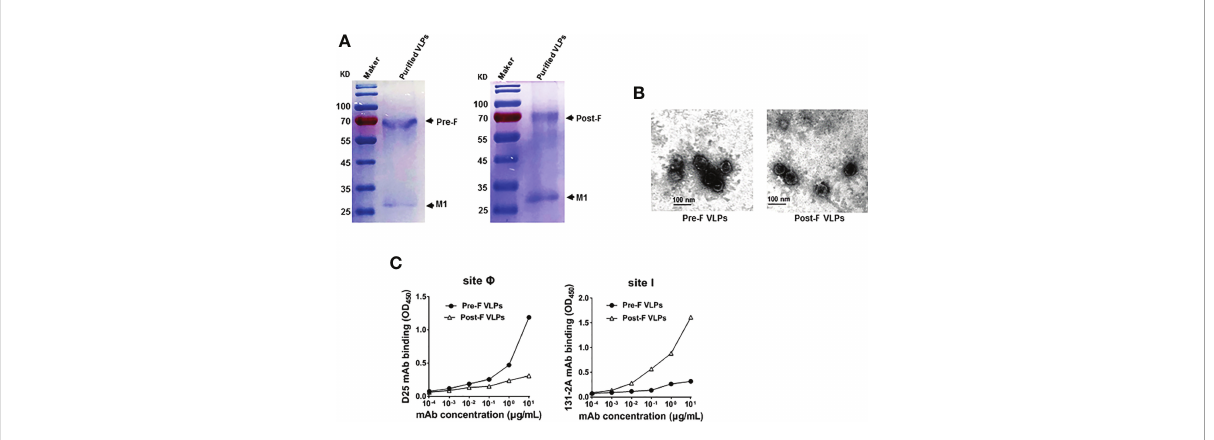
FIGURE 2 Puri fi cation and characterization of Pre-F VLPs and Post-F VLPs. (A) Puri fi ed proteins were subjected to 12% SDS − PAGE and stained with Coomassie blue. M, Molecular marker; Lane 1, Pre-F VLPs; Lane 2, Post-F VLPs. (B) Electron microscopic analysis of Pre-F VLPs and Post-F VLPs. Scale bar, 100 nm. (C) Monoclonal antibody speci fi cally binding to puri fi ed VLPs. Pre-F and Post-F VLPs containing equivalent amounts of F protein, as determined using mAb D25 or mAb 131-2A as the primary antibody and goat anti-human IgG-HRP for D25 (left) or goat anti- mouse IgG-HRP for 131-2A (right) as the secondary antibody, respectively. Antibodies and sites are indicated in the fi gure. OD, optical density.